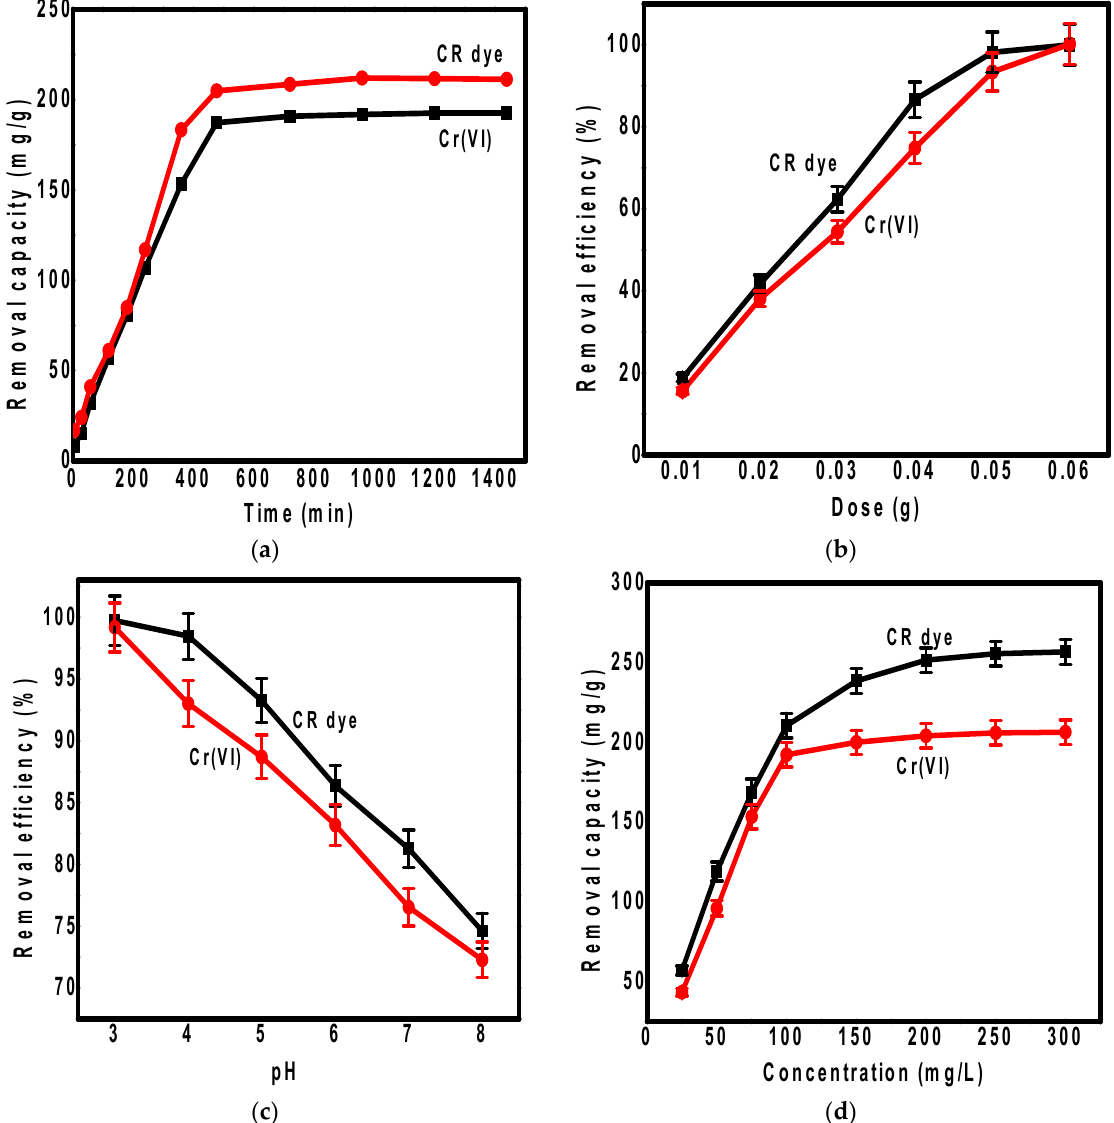
Figure 3. The contact time effect ( a ), adsorbent dosage effect ( b ), pH effect ( c ), and initial concentration effect ( d ) on the removal of Congo red dye and Cr(VI) from water using PPy/Fe 3 O 4 /SiO 2 nanocomposite.